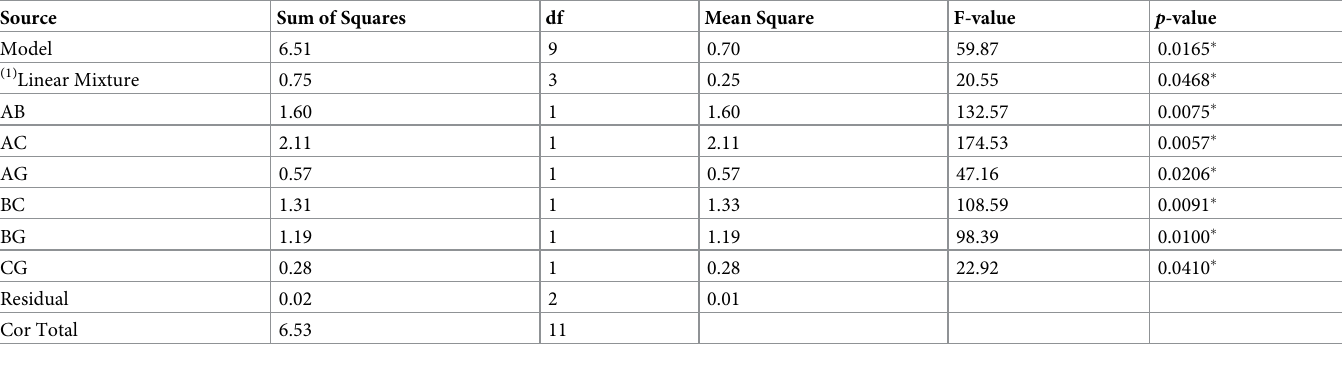
Table 7. ANOVA for a quadratic model for flowability.